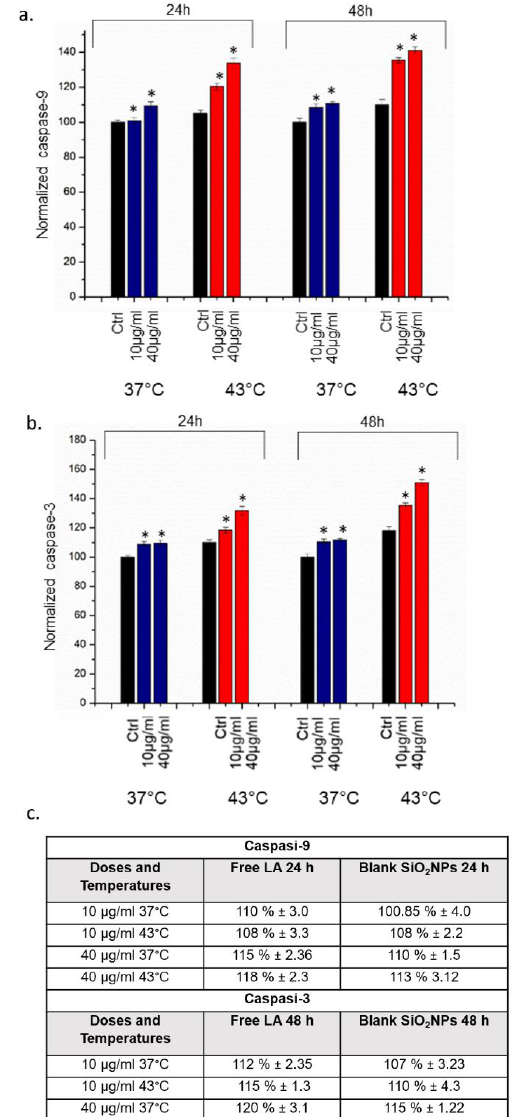
Figure 7. a , b E ff ect of SiO 2 @LA NPs on levels of apoptosis. Caspase-9 and Caspase-3 assay was performed incubating MCF-7 with of 10 µ g / mL and 40 µ g / m of NPs for 24 h and 48 h at 37 ◦ C and 43 ◦ C. Controls were represented by cells without SiO 2 @LA NPs exposure. c. Caspases 3–9 levels values obtained incubating MCF-7 with free LA and blank SiO 2 NPs at 10 µ g / mL and 40 µ g / m of NPs for 24 h and 48 h at 37 ◦ C and 43 ◦ C. Data are reported as mean ± SD from three independent experiments are considered statistically significant compared with control ( n = 8) for p value < 0.05 ( < 0.05 *). Confocal microscopy analyses of MCF-7 incubated with 10 µ g / mL and 40 µ g / mL of SiO 2 @LA NPs for 24 h and 48 h were reported. The changes in cell morphology were another proof to confirm the combined action on MCF-7 cells. The cells exposed only to heat treatment presented negligible ruffles in some cell regions (Figure 8).